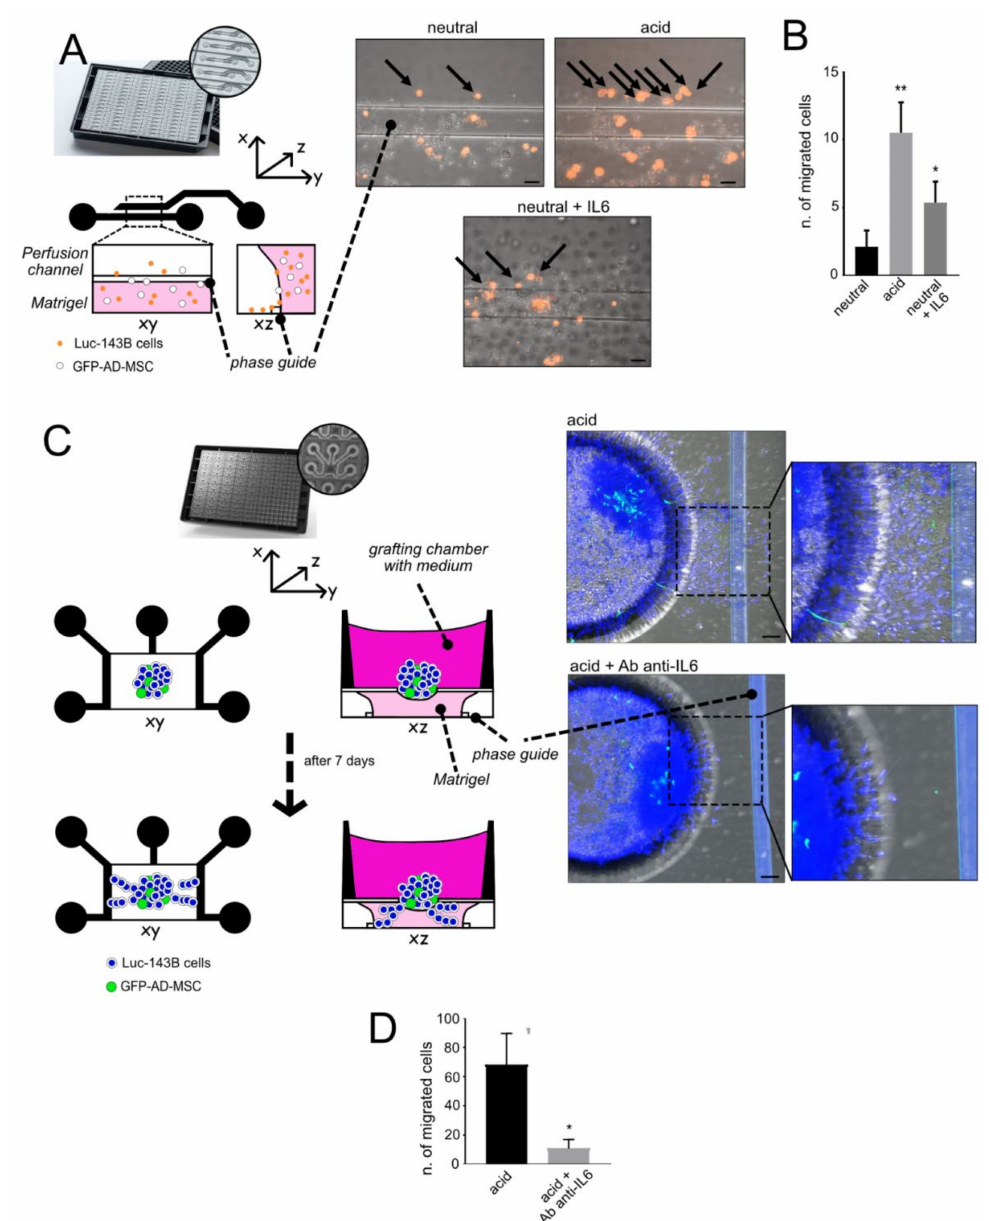
Figure 5. Extracellular acidosis favours the migration of tumour cells in 3D microfluidic cultures mimicking the acid TME. ( A ) Left panel: explanatory drawing of the experiment performed in the 2-lane microfluidic OrganoPlate ® ; right panel: representative images of the two channels in the microfluidic chamber in different conditions (black arrows indicate migrated tumour cells). Scale bar 20 µ m; ( B ) Quantification of cells migrated in the perfusion channel of the experiment shown in ( A ), only cells in the perfusion channel were counted (mean ± SEM, ** p < 0.01 and * p < 0.05 vs. neutral, Mann–Whitney U test); ( C ) Left panel: explanatory drawing of the experiment performed in the OrganoPlate Graft ® ; right panel: representative confocal images (and magnifications) of the spheroids placed in the grafting chamber, after 7 days, in different conditions, and stained with Hoechst 33342. Scale bar 50 µ m; ( D ) Quantification of the cells invading Matrigel ® in the grafting chamber, under the spheroids (* p < 0.05, Mann–Whitney U